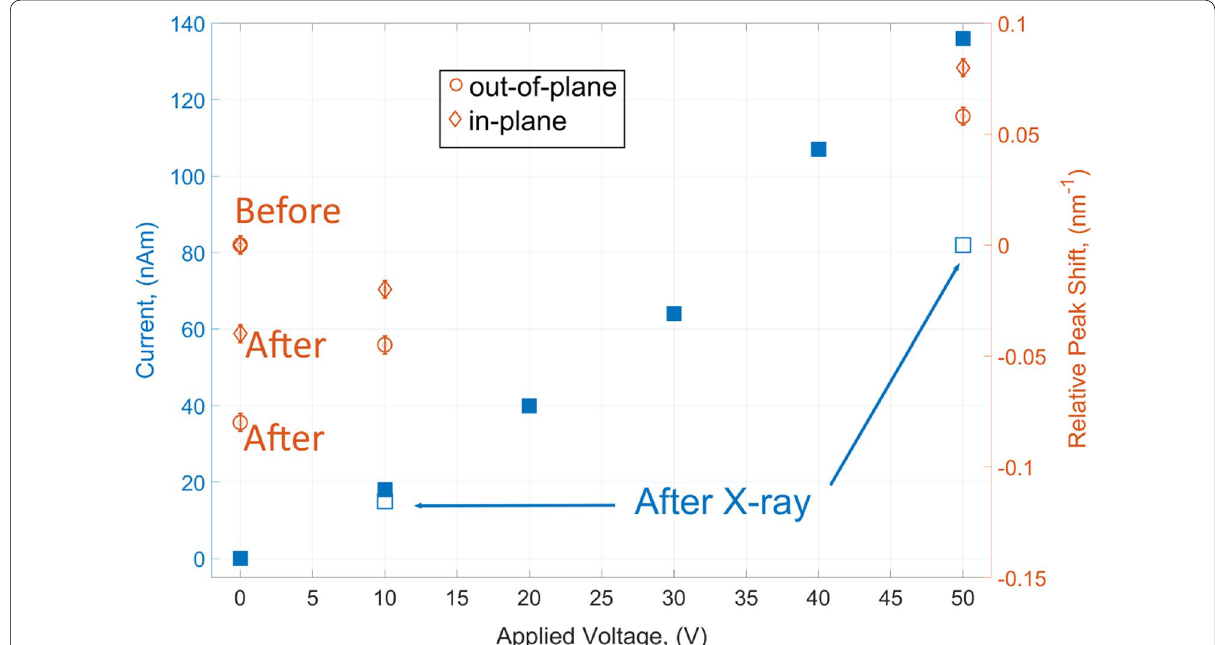
Fig. 4 At the blue axis: current response to the applied voltage during (filled squares) and after(empty squares) X-ray measurements; at brown axis: relative shift of the average peak position in in-plane(diamonds) and out-of-plane(circles)